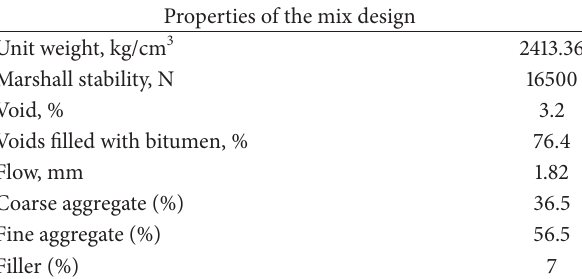
Table 2: Test results of the mix